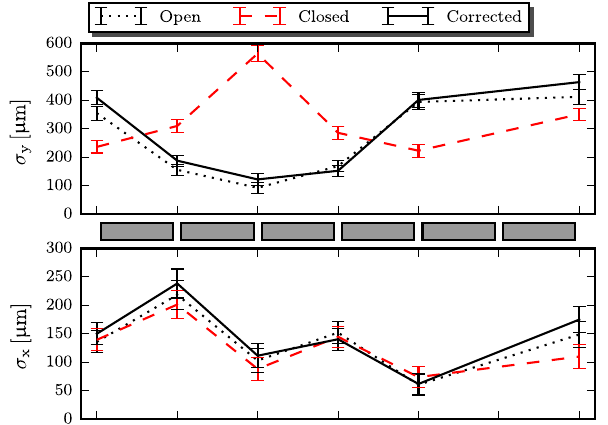
FIG. 7. Transverse beam sizes measured using the wire scanners between the six FLASH main undulator segments (grey boxes in the middle). The dotted curve shows the beam sizes at theory optics without any disturbance. Measurements of the disturbed case, where the seeding undulator is closed, are depicted by the dashed curve. The solid curve shows beam sizes with corrections applied. At the time of measurement, the wire scanner between the last two undulator segments was